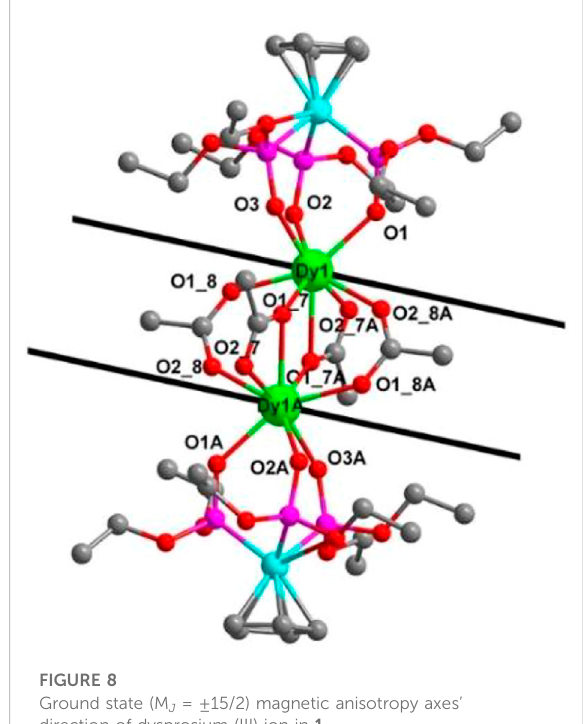
FIGURE 8 Ground state (M J = ±15/2) magnetic anisotropy axes ’ direction of dysprosium (III) ion in 1